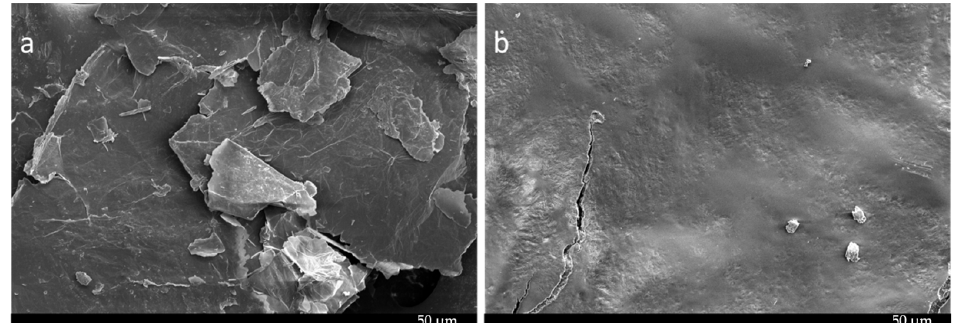
Figure 6. SEM image of ( a ) GO surface, ( b ) GO-SSS surface.